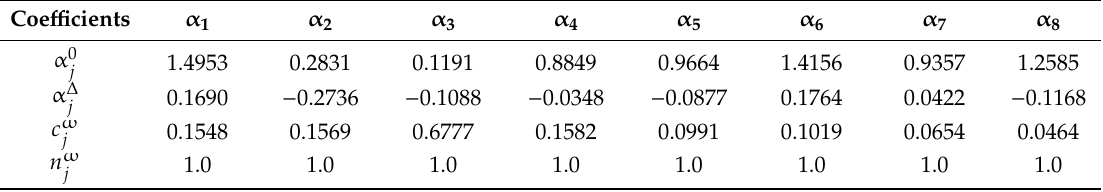
Table 5. Evolution coe ffi cients for the parameters of the yield function of the Q&P 980